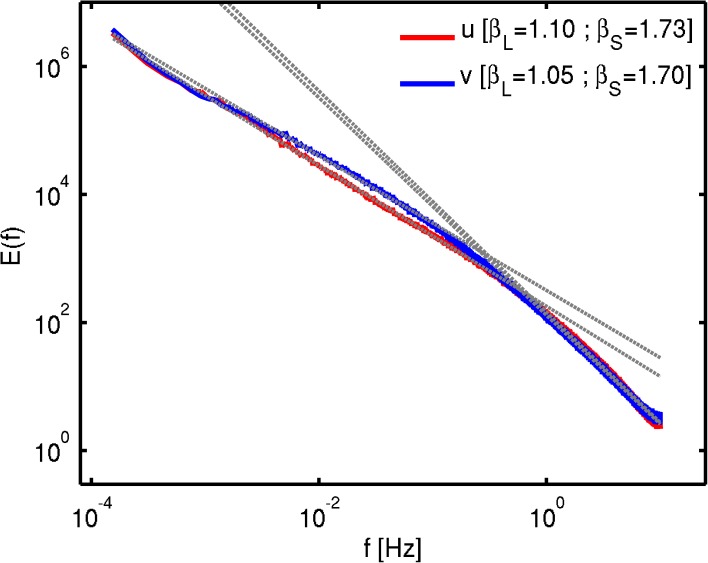
Ensemble Fourier power spectrum computed over all available ABL wind time-series realizations in the CASES-99 valid dataset.The red line represents the zonal wind component (u) and the blue line represents the meridional wind component (v).